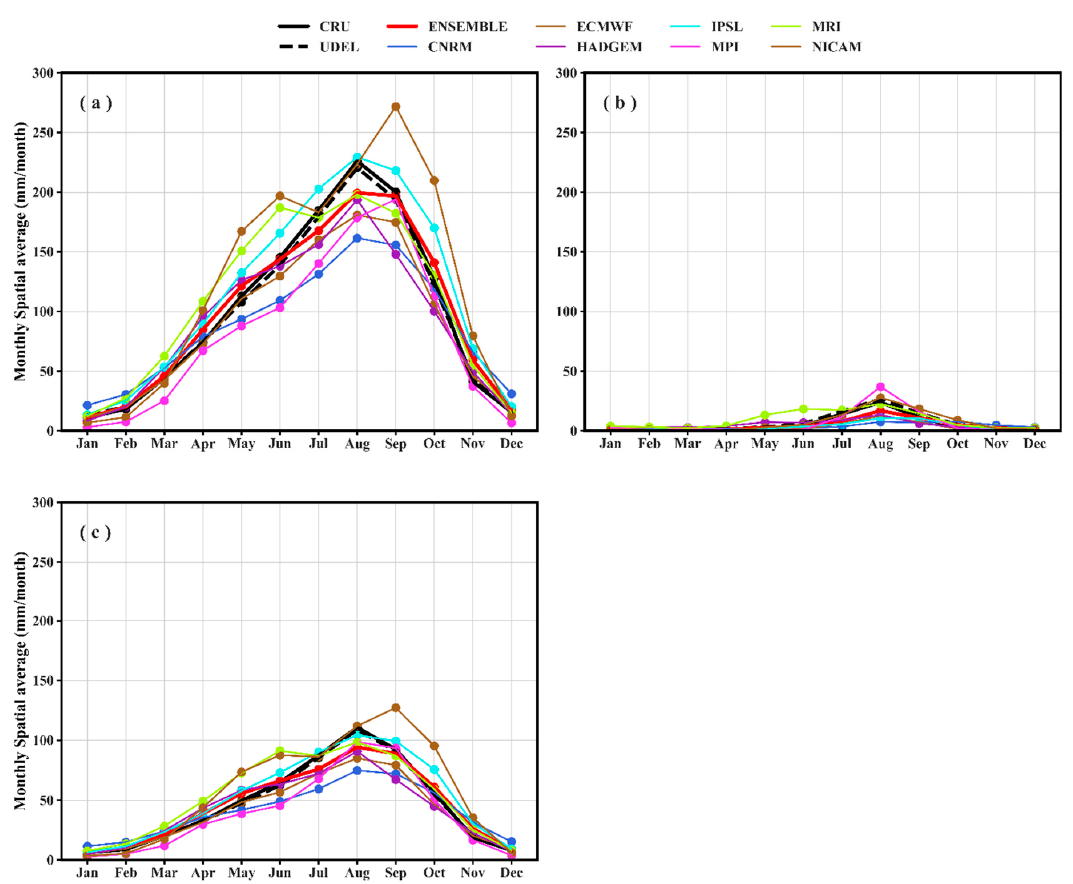
Figure 2. Comparison of monthly spatial average precipitation (mm / month) over ( a ) Guinea Coast, ( b ) Sahel, and ( c ) West Africa from 1985 to 2014.